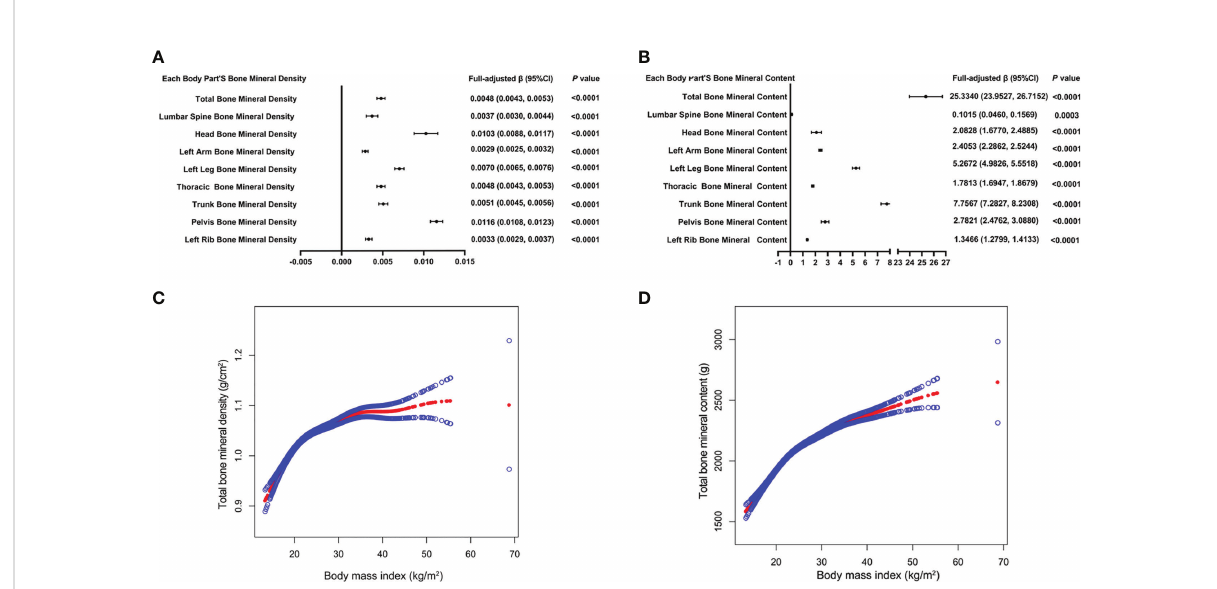
FIGURE 2 The forest plots of each body part ’ s bone mineral density or bone mineral content and body mass index, respectively (A, B) . Association of total bone mineral density and bone mineral content with body mass index (C, D) . The solid red line represents the smooth curve fi t between variables. Blue bands represent the 95% con fi dence interval from the fi t. All confounding factors were